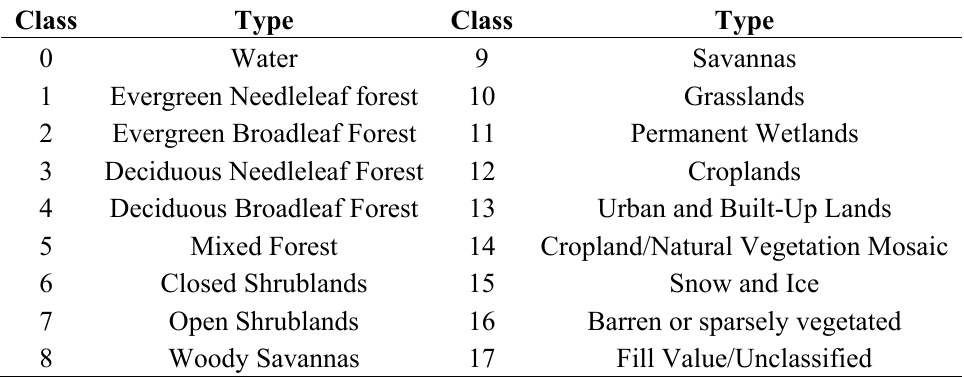
Table 1. International Geosphere Biosphere Programme (IGBP) land cover classification